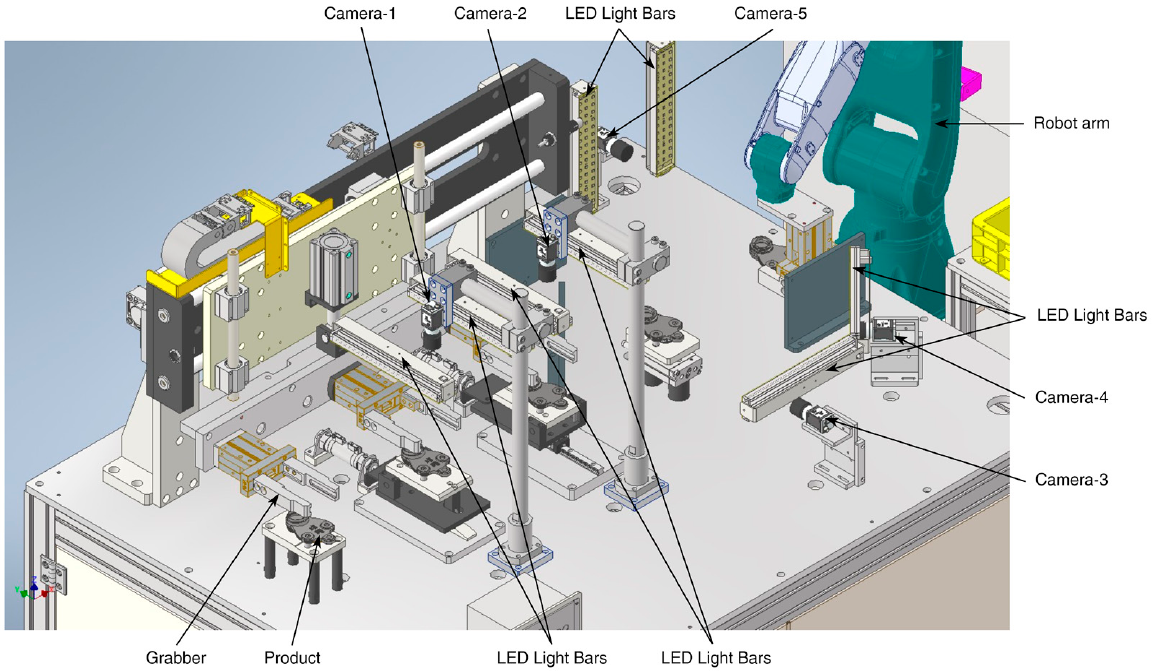
Figure 2. The 3D representation of the 3D ball joint socket defect inspection hardware system. LED—light-emitting diode.